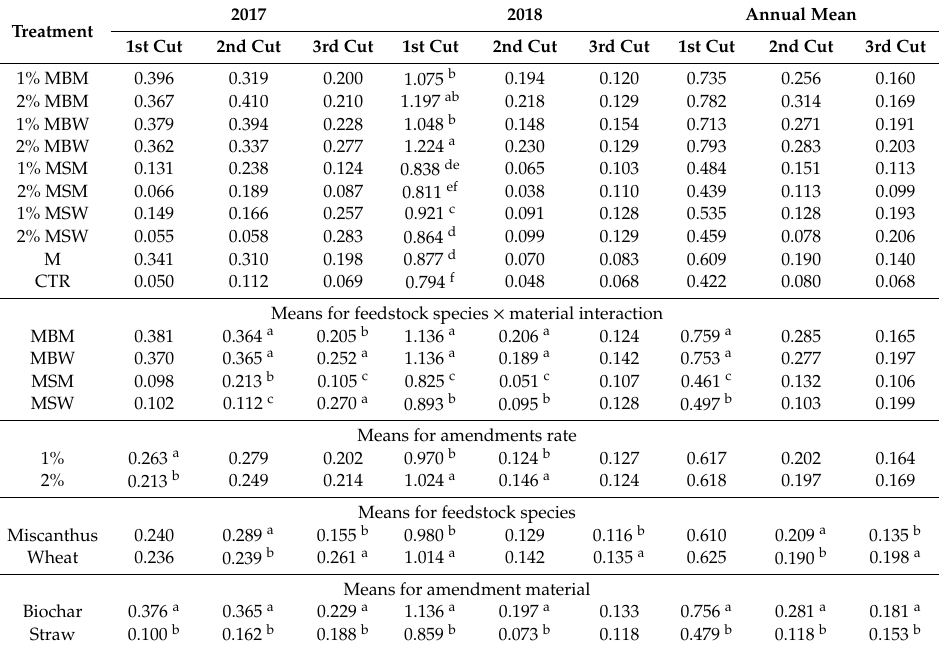
Table 3. Above-ground biomass production (kg DM m − 2 ) of perennial ryegrass. MBM, Miscanthus biochar with mineral fertilization; MBW, wheat biochar with mineral fertilization; MSM, Miscanthus straw with mineral fertilization; MSW wheat straw with mineral fertilization; M, mineral fertilization; CTR, without mineral fertilization and without any